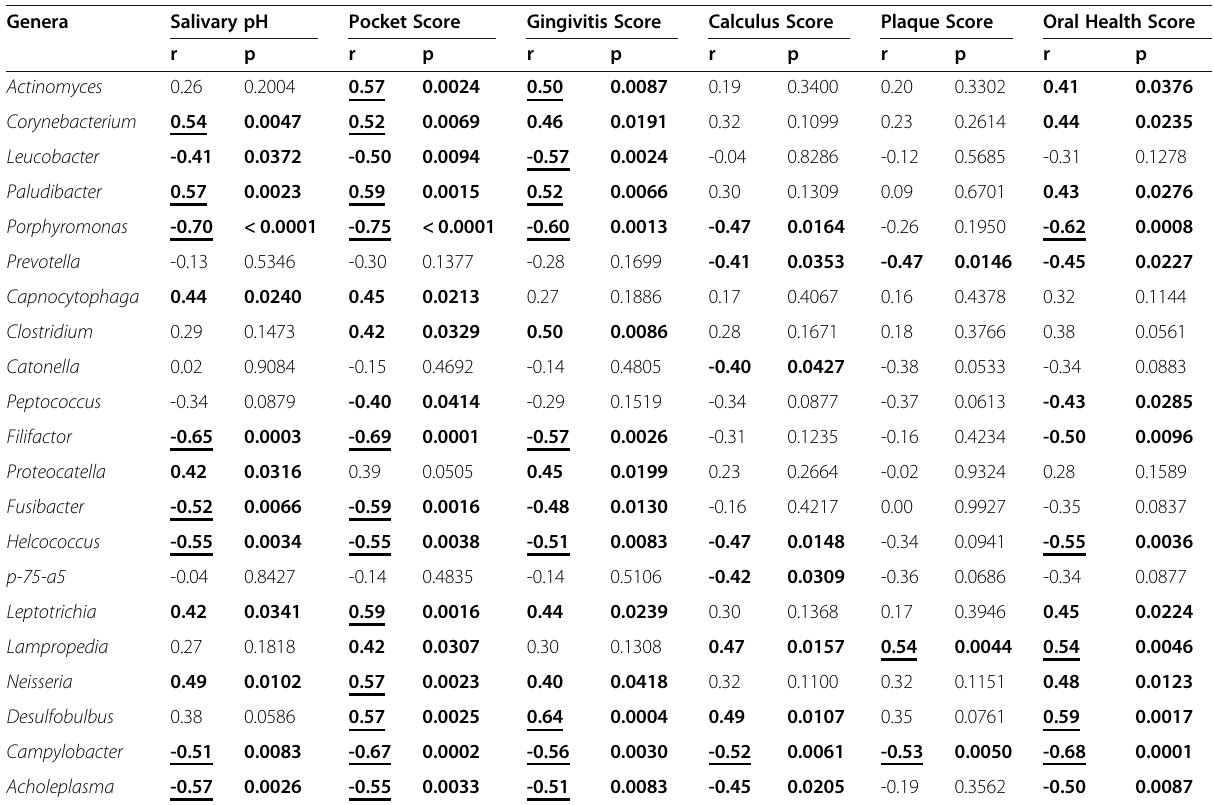
Table 8 Correlation coefficients (r) between oral health scores, plaque scores, calculus scores, gingivitis scores, pocket scores, pH and bacteria genera in supragingival samples